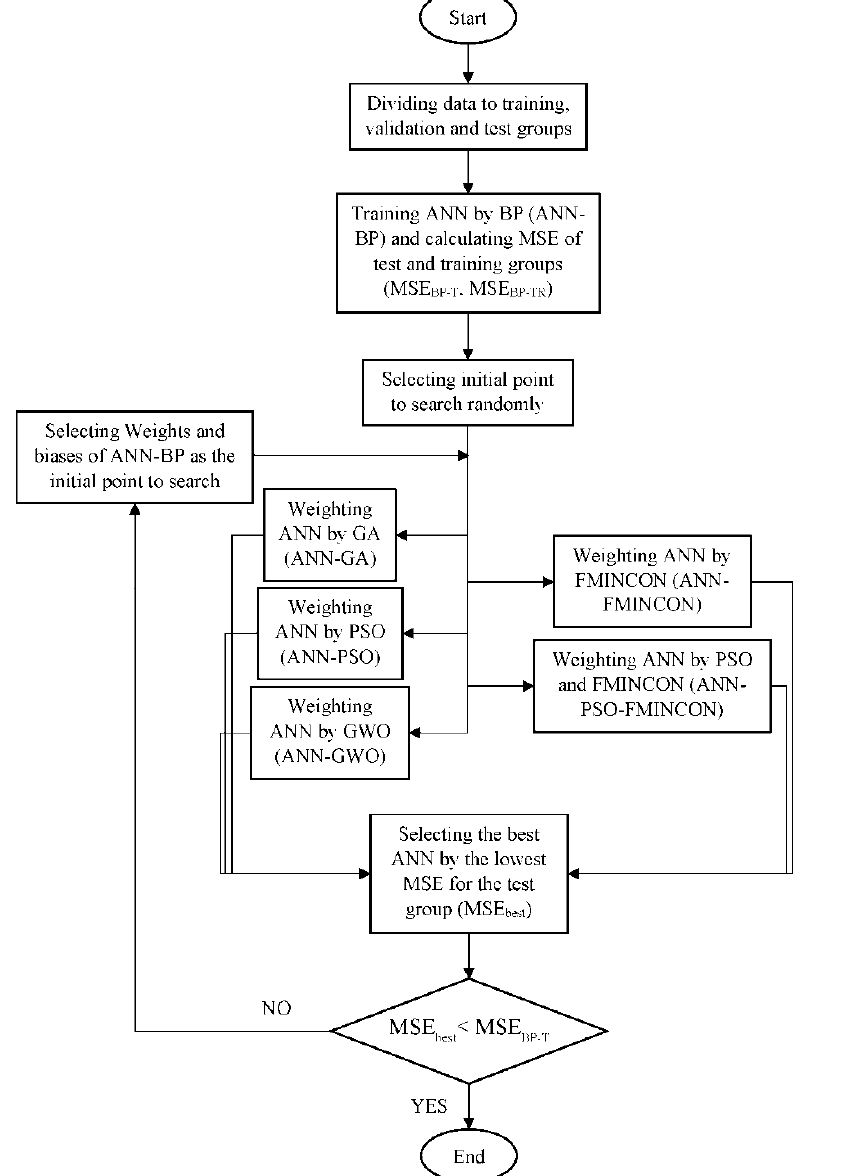
Figure 4. Proposed approach for weighting the ANN.